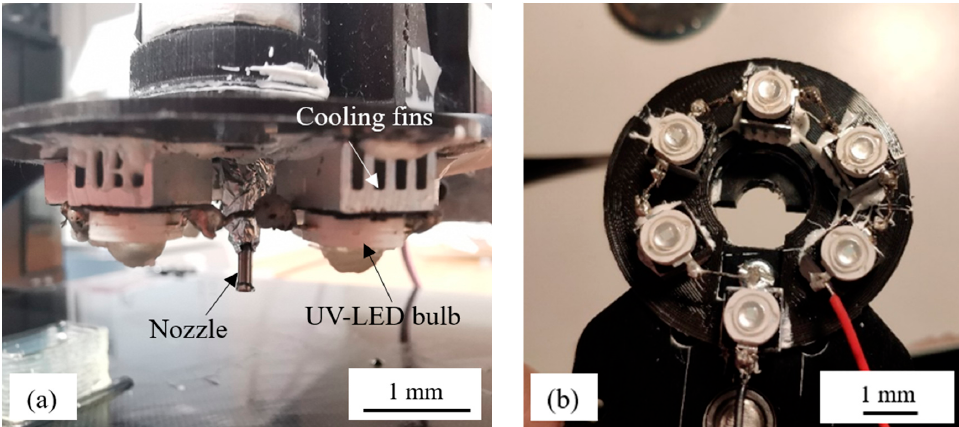
Figure 1. ( a ) Nozzle region design; ( b ) distribution of six UV lights.